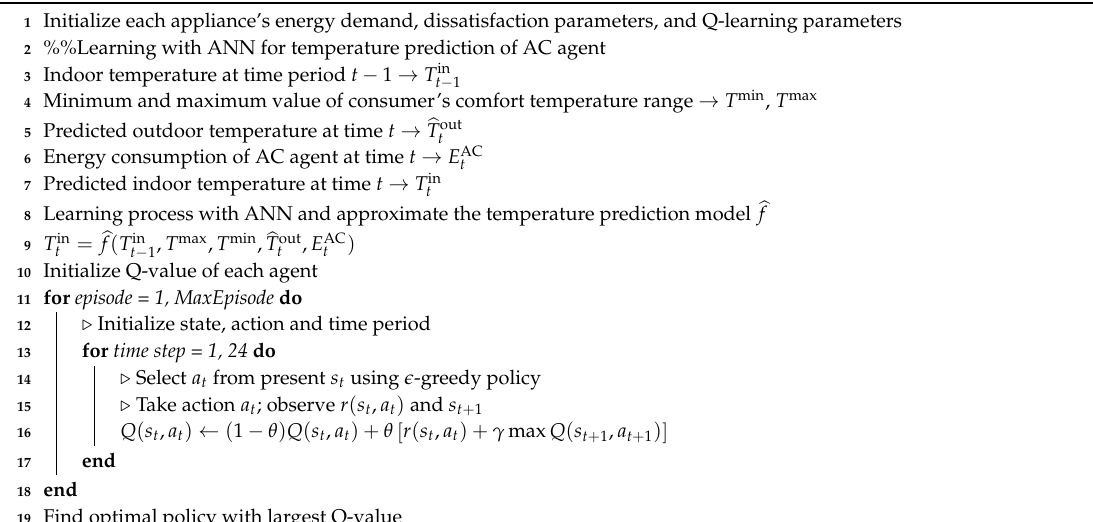
Algorithm 1: Q-learning-based energy management of smart home with PV system, ESS, and home appliances.